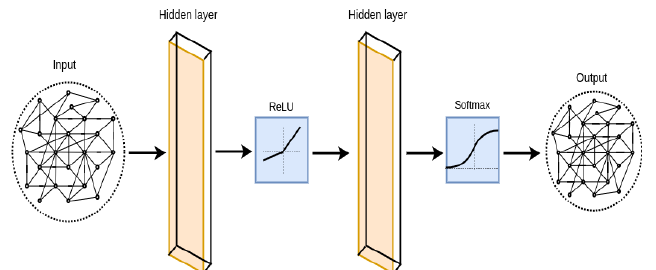
Figure 2. Semi-supervised node classification through a GCN